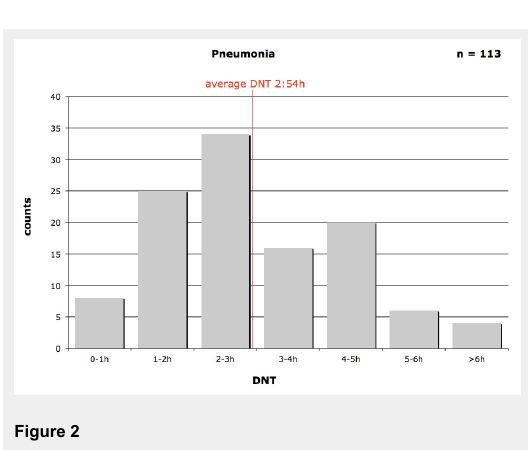
Door-to-needle-time (DNT) in community acquired pneumonia patients.